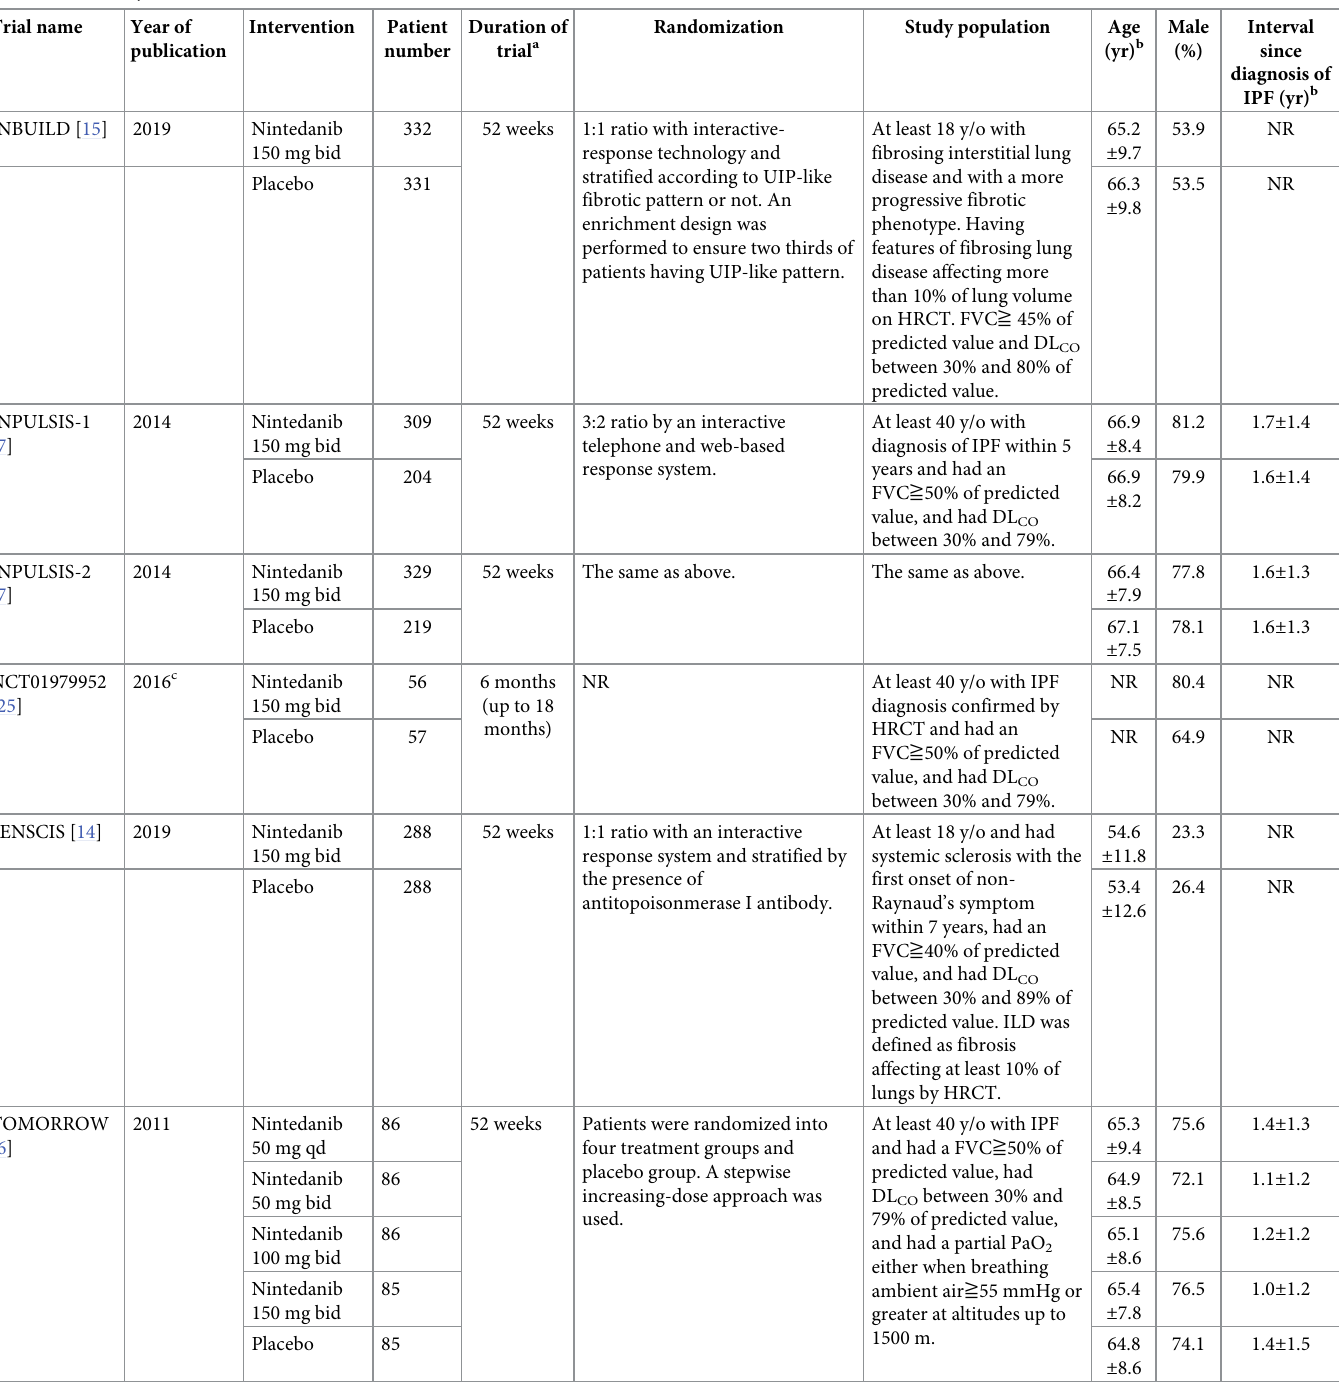
Table 1. Summary of baseline characteristics of included